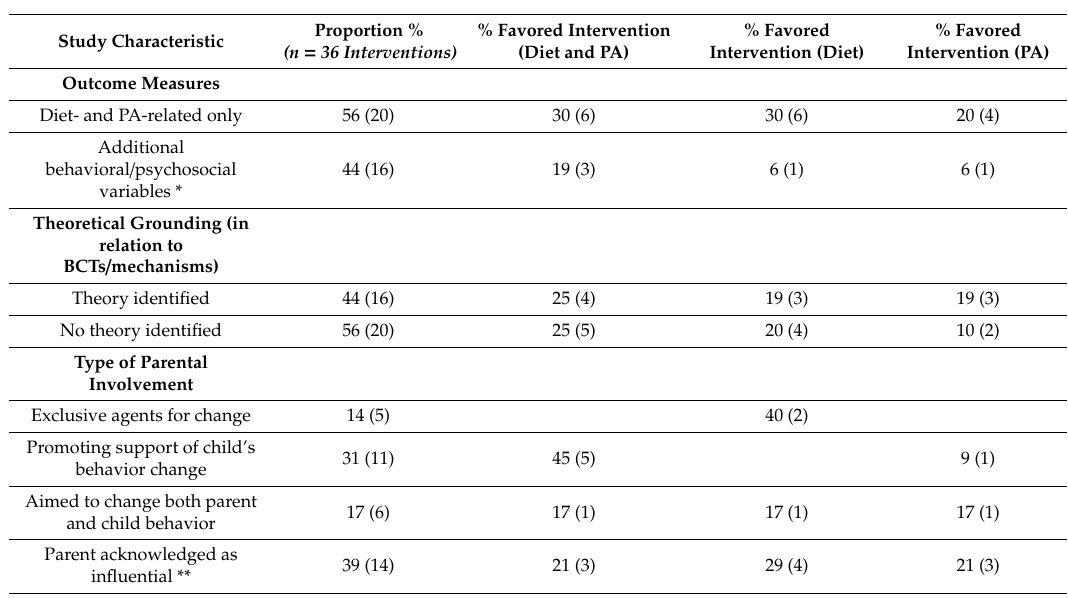
Table 3. Outcome measures, theoretical grounding, and type of parental involvement in 36 interventions included in systematic review of family-based weight-management programs with diet and physical activity behavioral